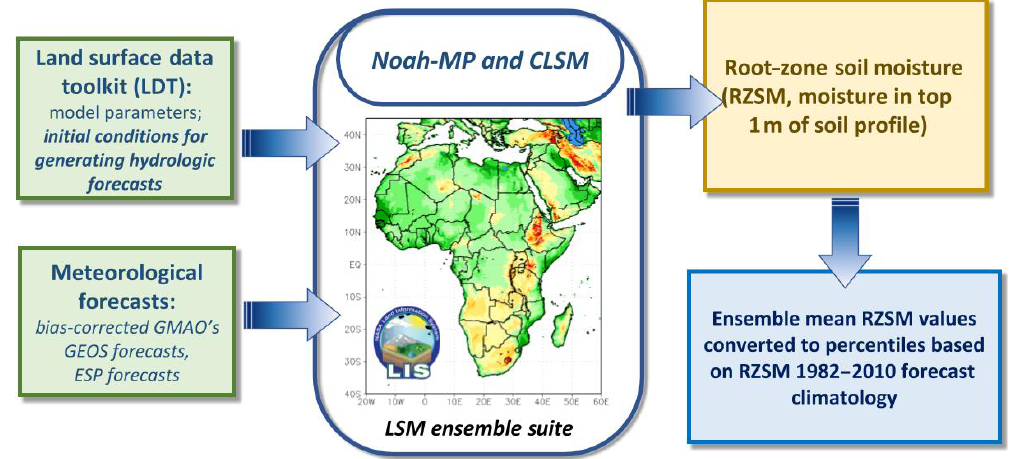
Figure 3. Overview of the NHyFAS implementation to produce RZSM monitoring and forecasting products, as used in this study.